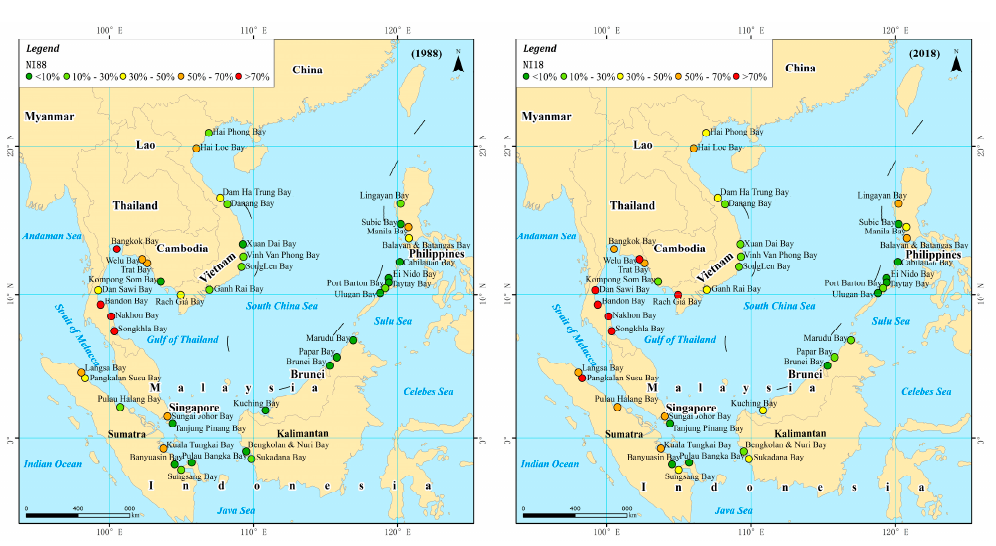
Figure 7. NI of the bays in 1988 and 2018.